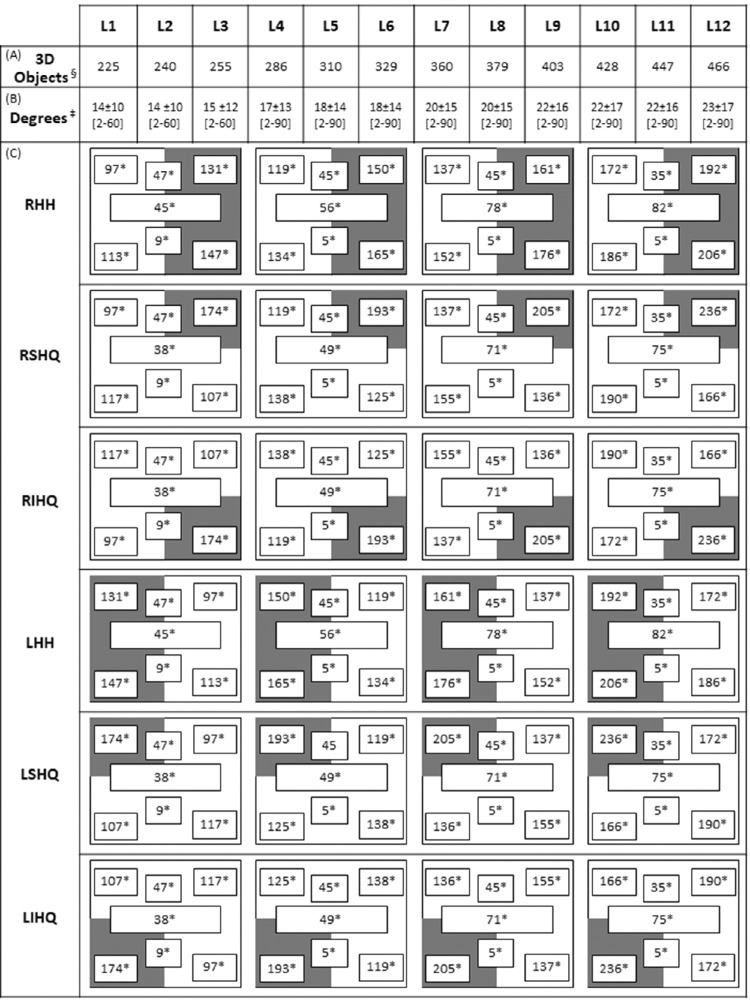
The schematic summary of the six different customized versions of the 3D-MCSTP according to the six more prevalent types of hemianopia and quadrantanopia. Each version had 12 common levels (Ln) of difficulty based on increases level by level of the variables. (A) §The total number of 3D real-world objects. (B) ‡The number of trained horizontal degrees (mean ± SD) (range). (C) *The total visual distracting stimuli located on the worktable at seven spatial locations (gray indicates the blind field and white the seeing field). Note: All included values correspond to the mean value obtained by considering both daily training sessions. RHH, right homonymous hemianopia; RSHQ, right superior homonymous quadrantanopia; RIHQ, right inferior homonymous quadrantanopia; LHH, left homonymous hemianopia; LSHQ, left superior homonymous quadrantanopia; LIHQ, left inferior homonymous quadrantanopia.